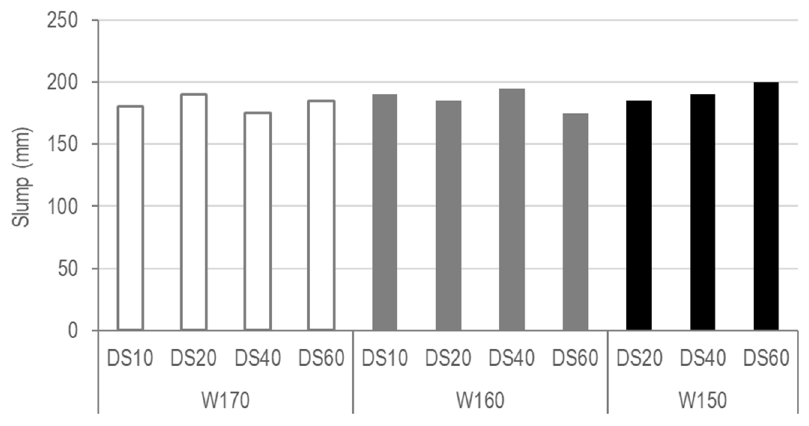
Figure 2. Particle-size distributions of the FAs used in this study.